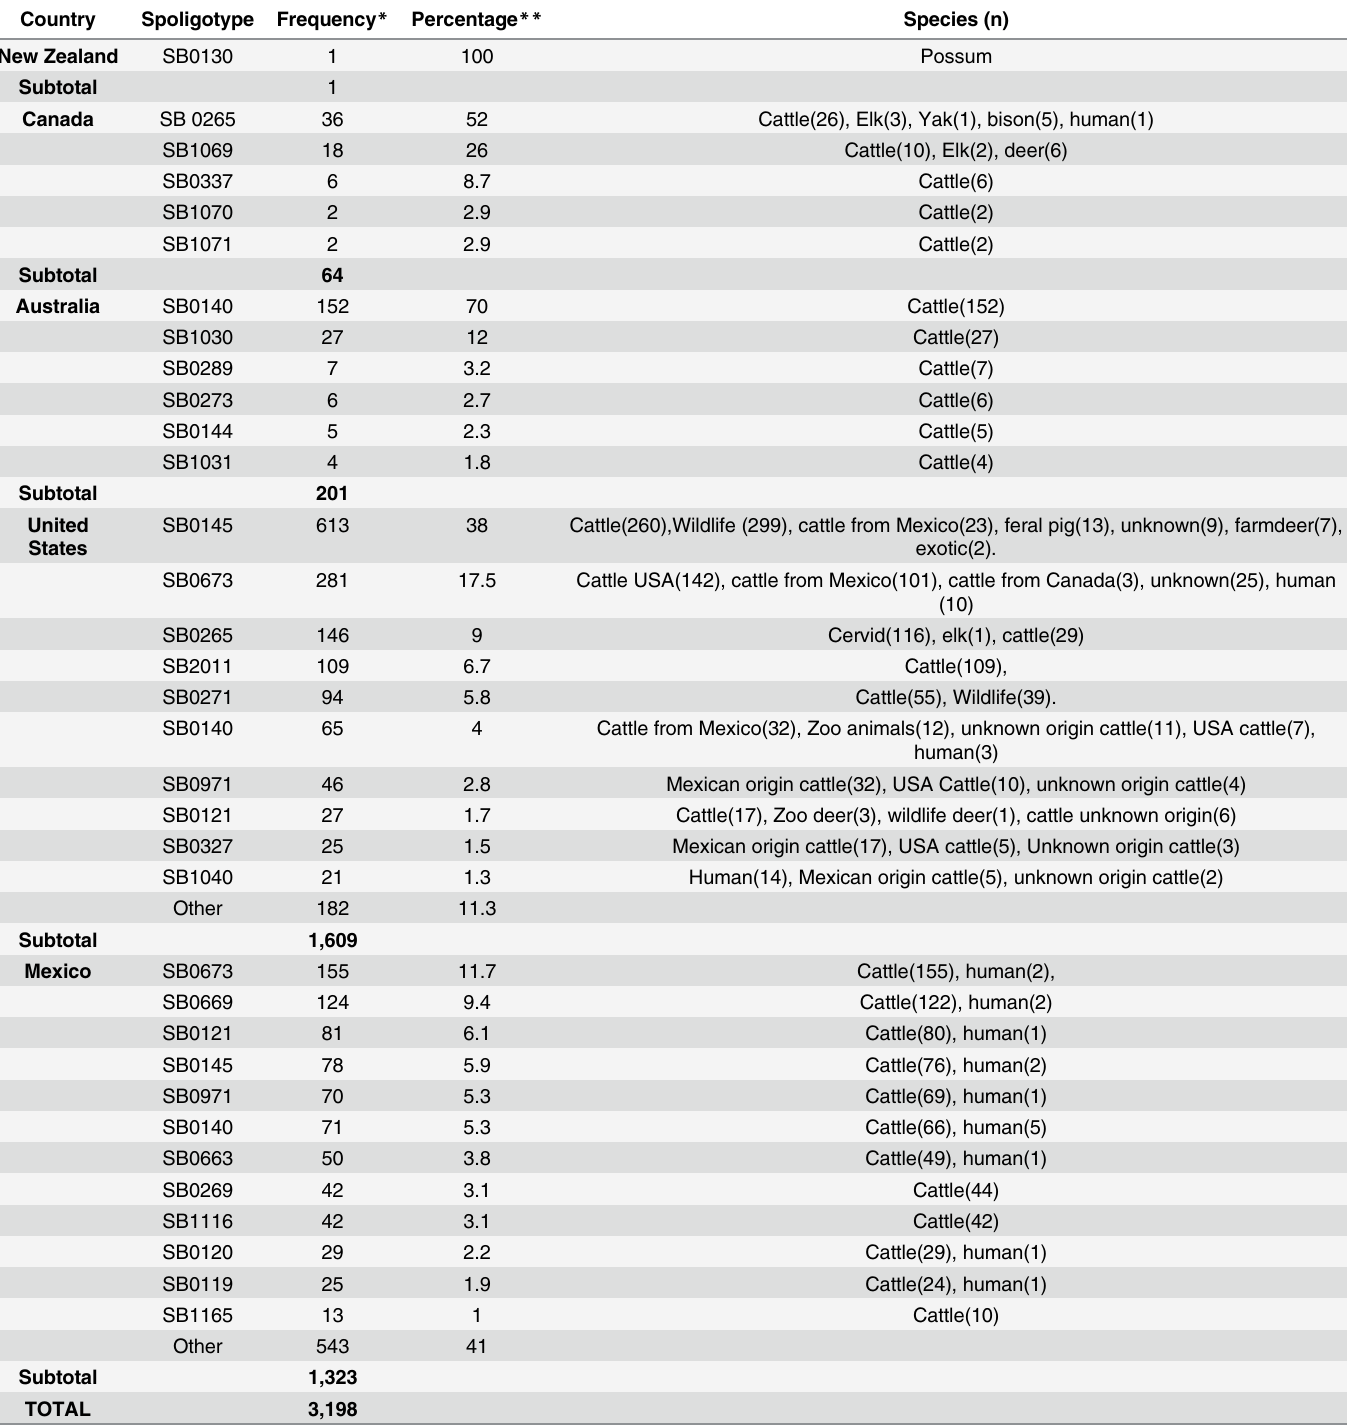
Table 1. Most Frequent spoligotypes of M . bovis from Mexico and countries with history of free trade of cattle with Mexico.